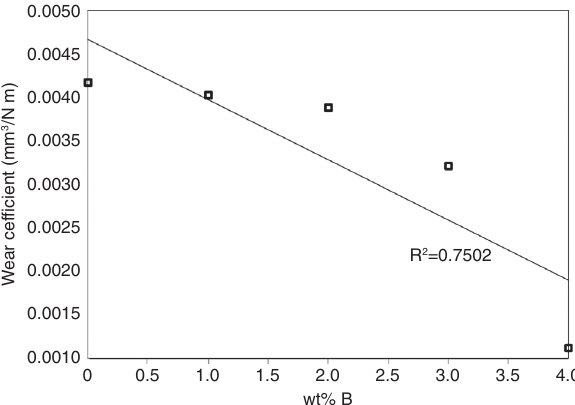
Figure 4 Wear coefficient measured on the tested samples as a function of boron content in the composites.